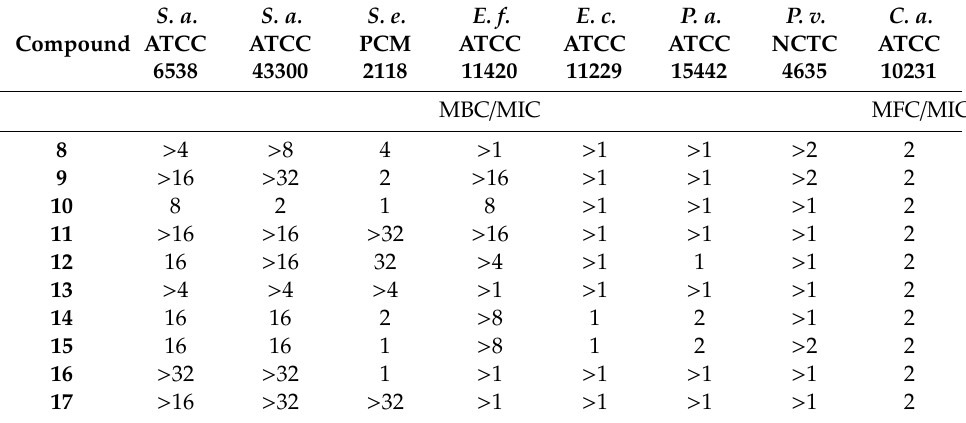
Table 3. The MBC / MIC and MFC / MIC ratios for compounds 8 – 17